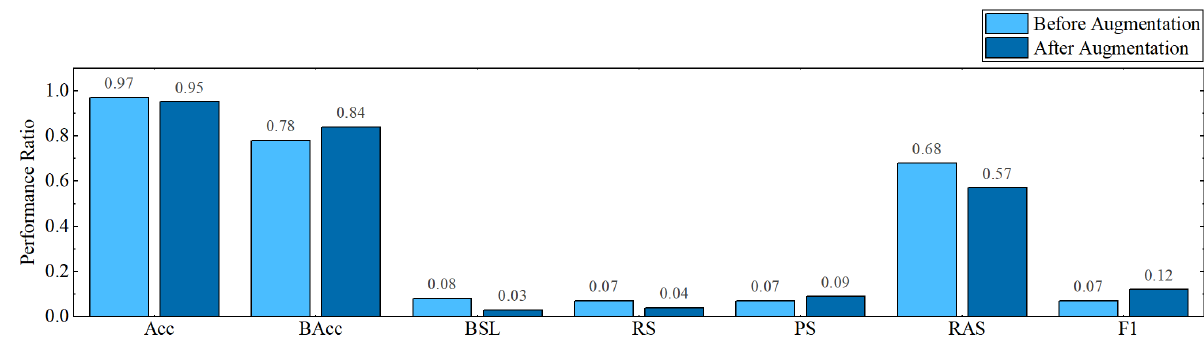
Figure 9. Performance ratios of the proposed CNN model, before and after cleaning and augmentation.